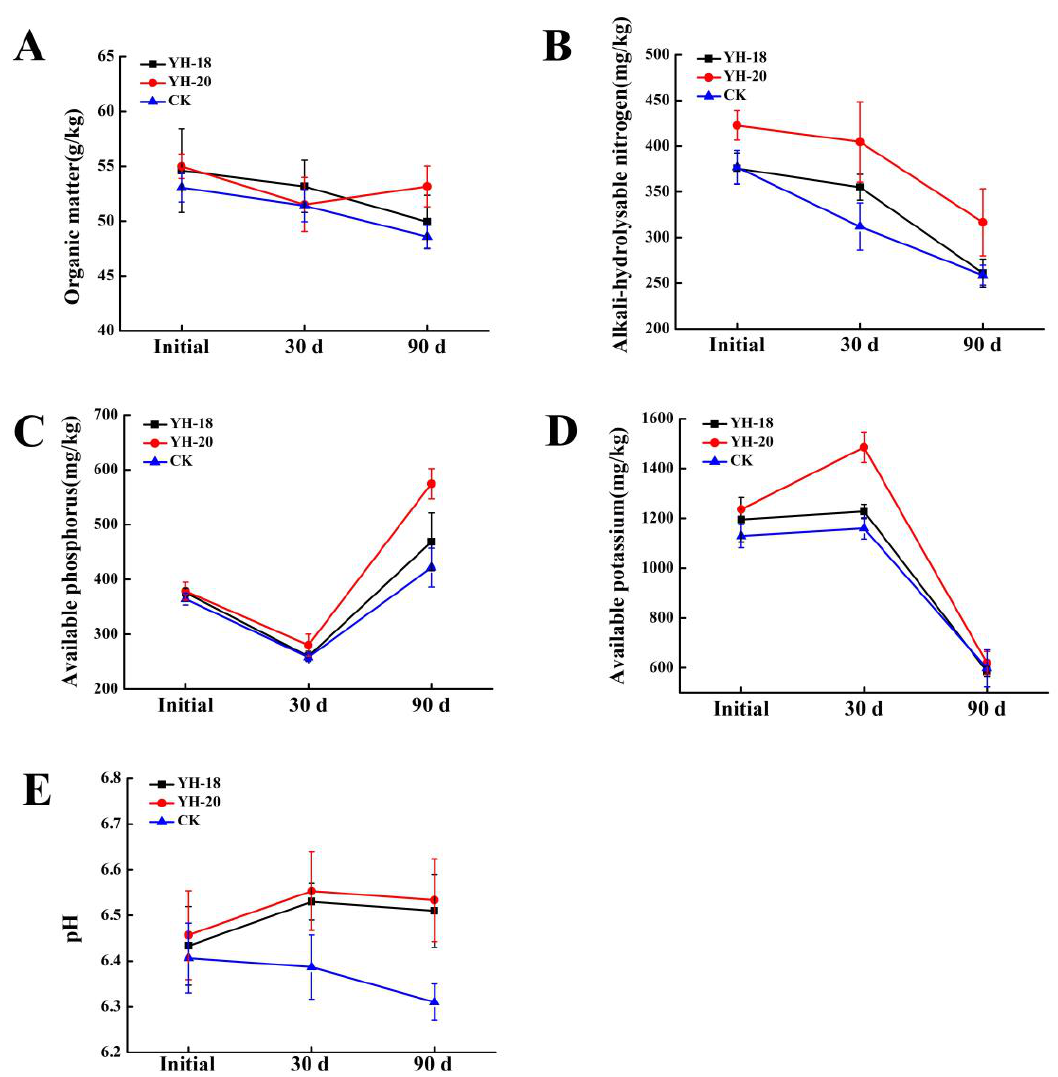
Figure 2. Effects of YH-18 and YH-20 microbial inoculants on ( A ) OM, ( B ) AN, ( C ) AP, ( D ) AK, and ( E ) pH in soil.